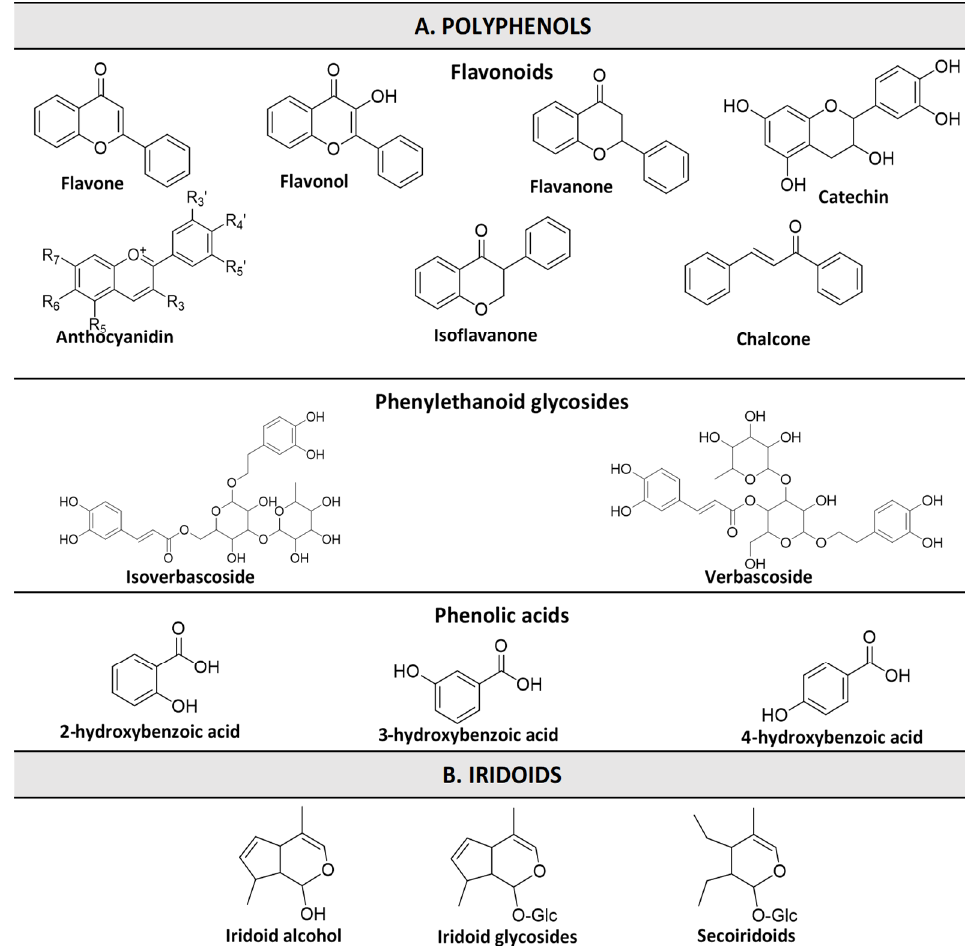
Figure 2. Chemical structures of polyphenols and iridoids present in V. sinuatum . Many studies have evaluated the polyphenolic profile of the extracts of the aerial part of V. sinuatum . For instance, a study evaluated the phenolic profile of the ethanolic extracts (maceration at room temperature for 72 h with ethanol at 70%) of V. sinuatum flowers from three different origins in Iran [21]. Spectrophotometric results showed that the total phenolic content of the three samples ranged from 29.03 mg gallic acid equivalents (GAE)/g dry weight (DW) to 54.77 mg GAE/g DW, while the total flavonoid content varied between 13.72 mg rutin equivalents (RE)/g DW and 19.91 mg RE /g DW. Further quantitative analysis, carried out with high-performance liquid chromatography with photodiode-array detection (HPLC–PDA), identified apigenin (5.85–13.82 µ g/mg DW), luteolin (3.18–16.98 µg/mg DW), naringin (7.10–12.32 µg/mg DW), rutin (4.90–5.55 µg/mg DW), and caffeic acid (4.98–7.78 µg/mg DW). Other authors have evaluated the total phenolic content (TPC), total flavonoid content (TFC), and the phytochemical profile of the compounds present in the methanolic extracts (maceration at room temperature, 24 h) of flowers of different species of the genus Verbascum , including V. sinuatum [7]. For TPC and TFC, spectrophotometric methods were employed, and the results showed values of 51.94 mg GAE/g DW and 22.57 mg quercetin equivalents (QE)/g DW, respectively, which were the greatest among the studied species. Main phenolic compounds were identified and quan- tified by HPLC–PDA coupled with mass spectrophotometry (HPLC–PDA–MS). Thirteen phenolic compounds were identified, the largest being the flavonoid rutin (21.00 mg/g DW) and the phenolic acid ρ -Coumaric acid (10.22 mg/g DW). Further phytochemical analysis qualitatively identified other 20 compounds in the methanolic extracts, among